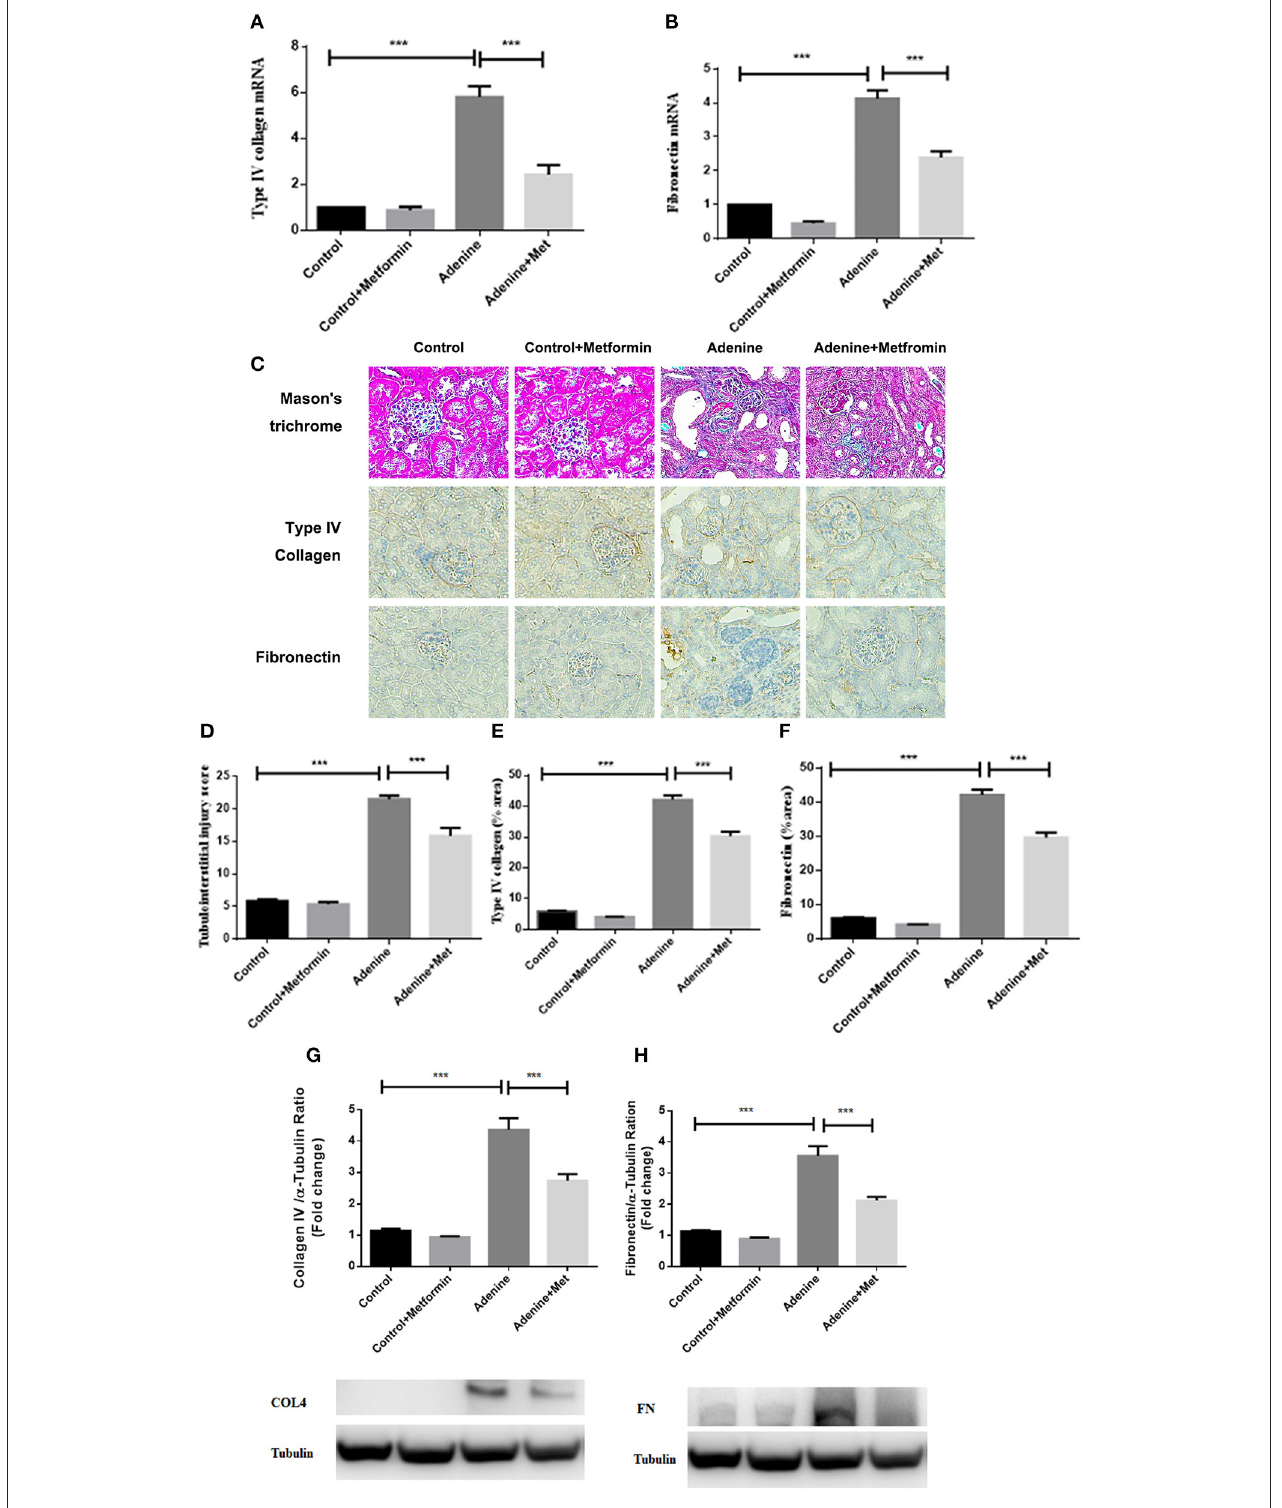
FIGURE 2 | Metformin reduces extracellular matrix deposition and tubulointerstitial fibrosis in a mouse model of adenine-induced renal injury. qRT-PCR results showed that the mRNA level of type IV collagen (A) and fibronectin (B) were significantly increased in adenine-induced mice compared to the control